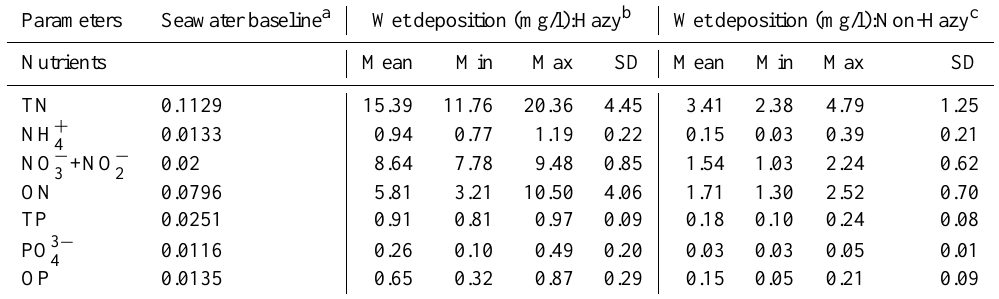
Table 2. Concentration of nutrients (N and P species) in seawater and atmospheric wet deposition during hazy and non-hazy days in Singapore.